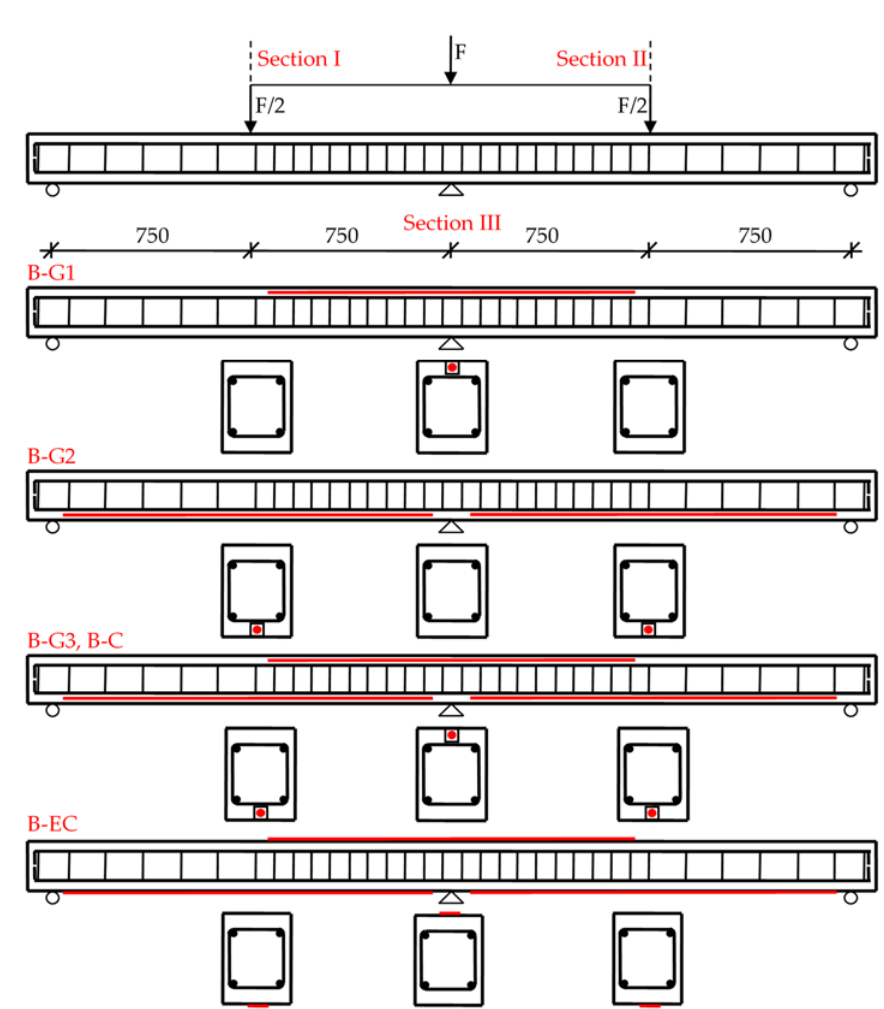
Figure 6. Variants of strengthening of tested beams.